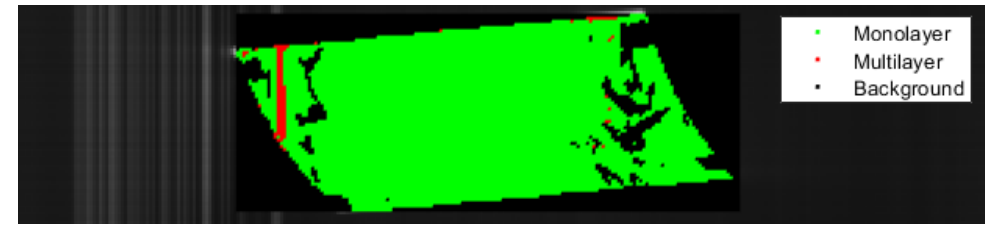
Figure 23. Classification of a PE monolayer film with the SNN.